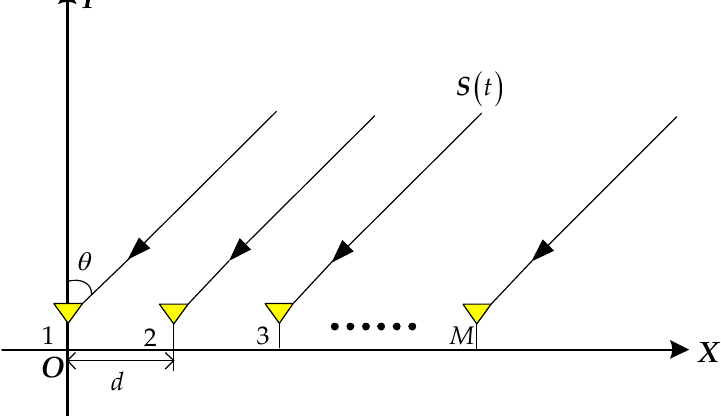
Figure 1. The modeling scheme of measured data.